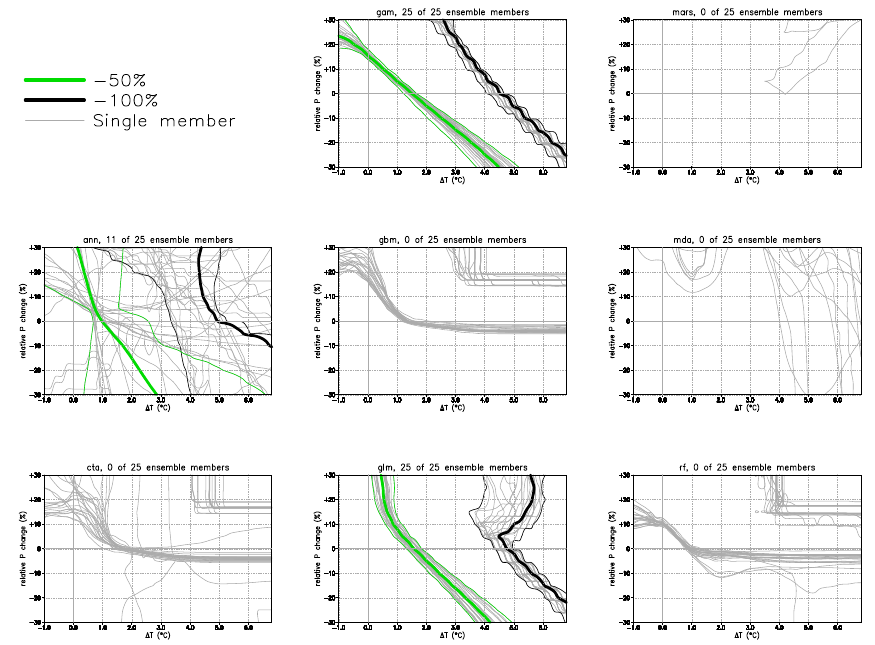
Fig. A2. As in Fig. A1, but for models calibrated for the 1961–1990 baseline period.